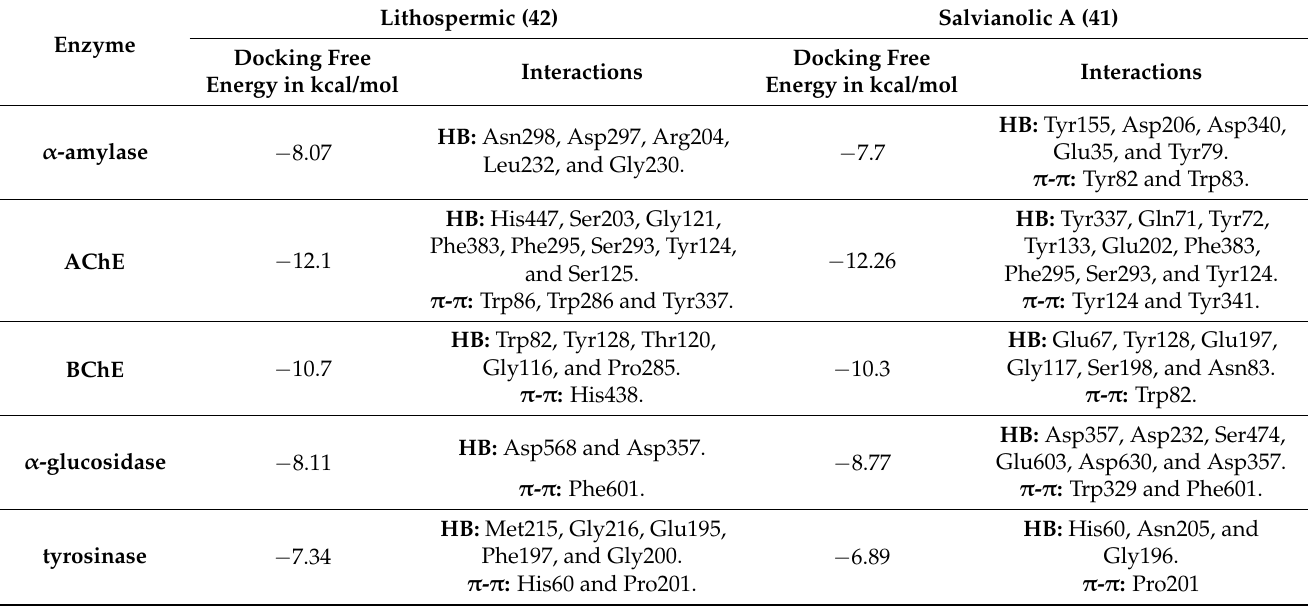
Table 6. Interactions of lithospermic acid ( 42 ) and salvianolic acid A ( 41 ) with α -amylase, AChE, BChE, α -glucosidase, and tyrosinase